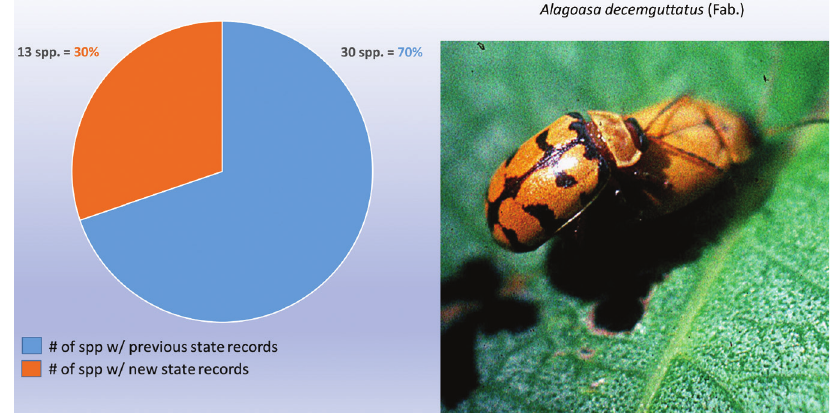
Figure 1. Alagoasa Bechyné new state records versus previously recorded state records.